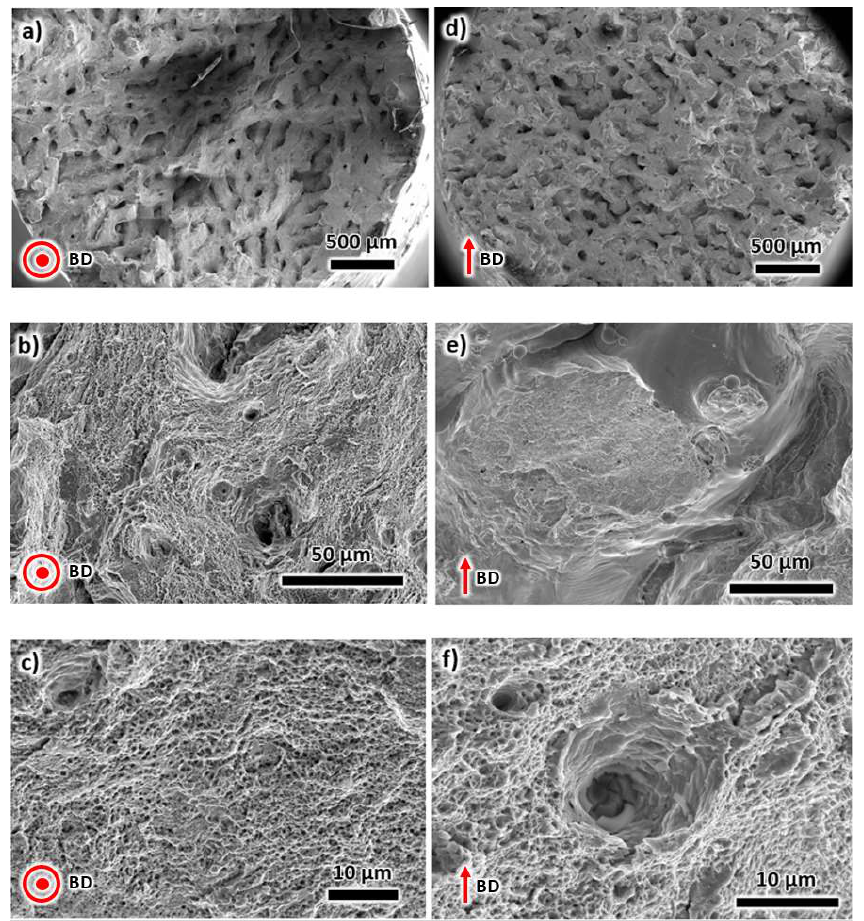
Figure 10. SEM images of the fractured surface of the AP sample tensile tested along the BD ( a – c ), and the TD ( d – f ).